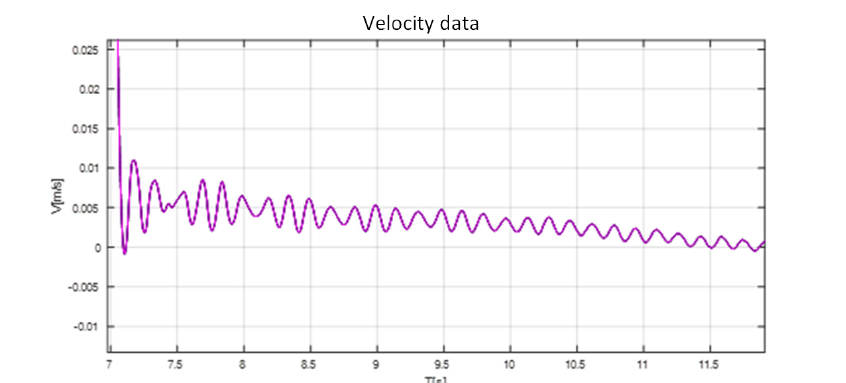
Figure 7. Velocity plot obtained with MTi XSENS installed on robot flange and welding gun for V2000, ACC100.